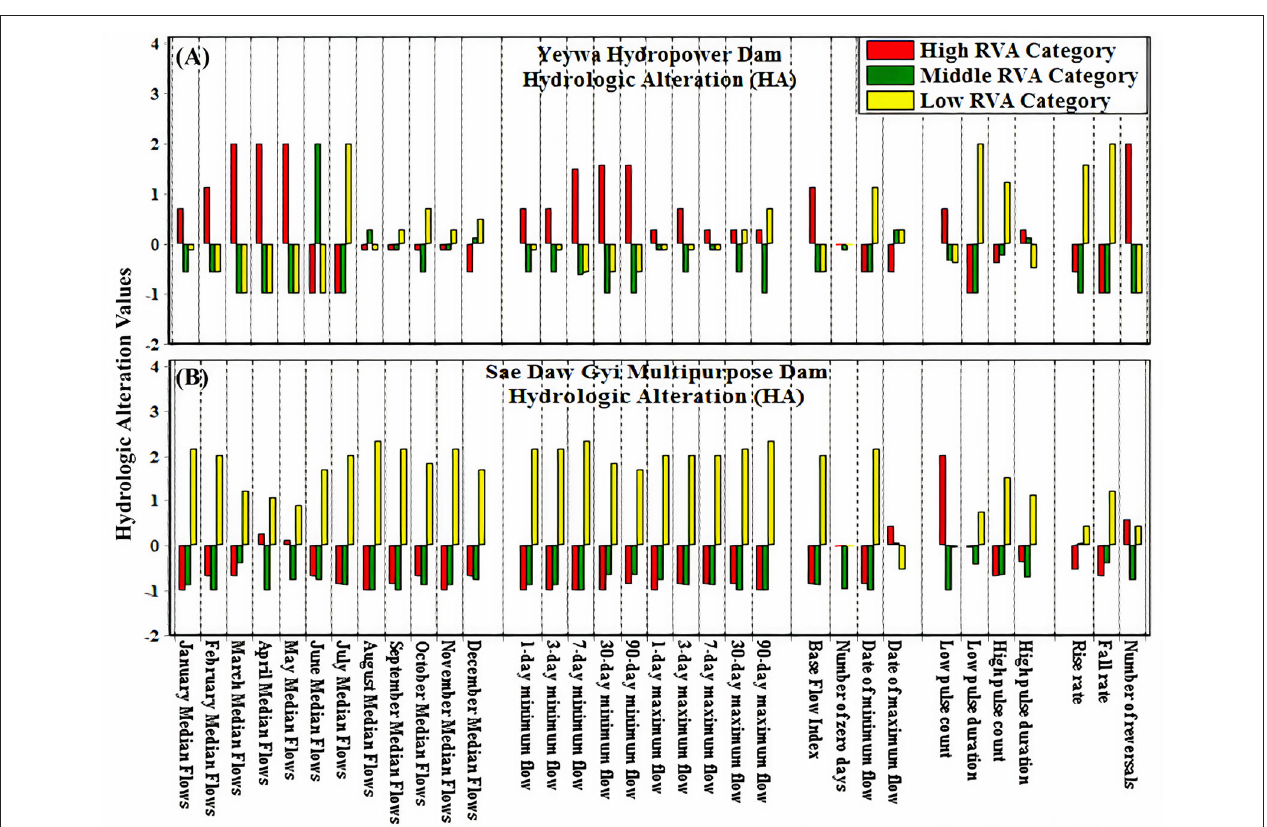
FIGURE 3 | The Results of Hydrologic Alteration (HA) with three different RVA categories (A) in Myitnge (Yeywa) and (B) Chaungmagyi (Sae Daw Gyi) Rivers; positive HA values indicate a higher frequency, magnitude, and duration of values in the given range of RVA (Low, Middle, High).